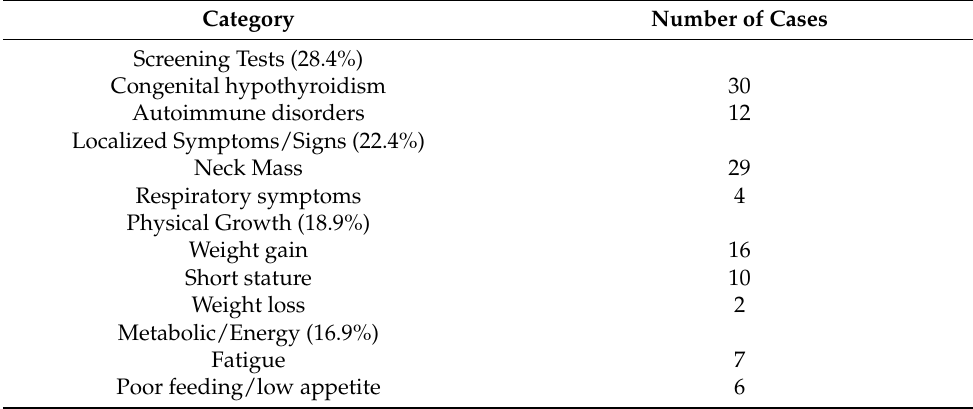
Table 3. Referral Causes by